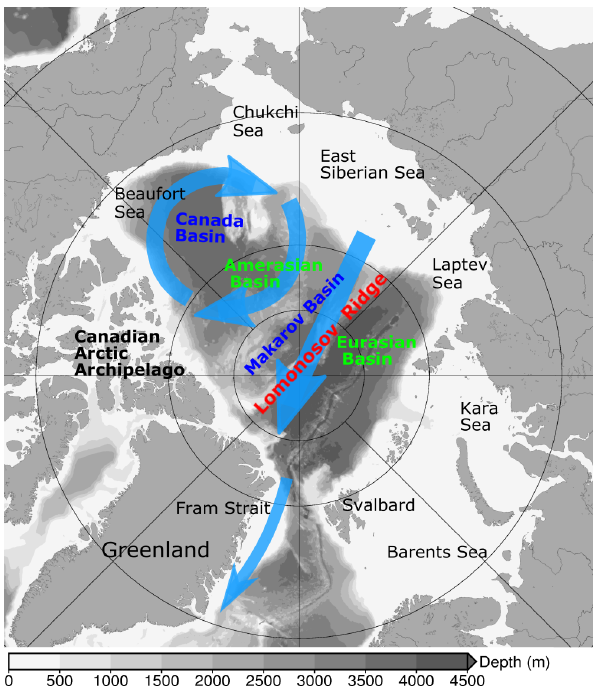
Figure 1. Arctic geographic features and schematic of Arctic sea ice circulation (the anticyclonic Beaufort Gyre circulation over the Canada Basin, the Transpolar Drift across the central Arctic and the sea ice export through the Fram Strait, shown as blue arrows). The background gray color shows bottom